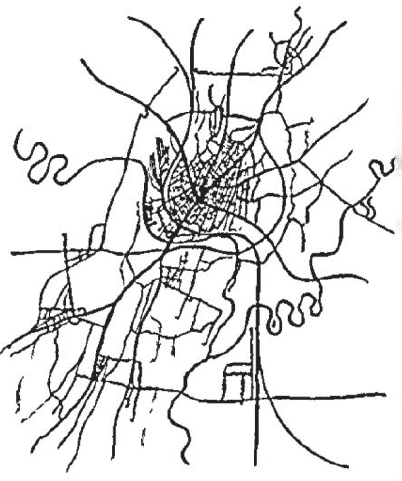
Figure 2. The Creeper (The body of humanity) [8] (p.154). Reproduced with permission of the Shollond Trust. Shollond